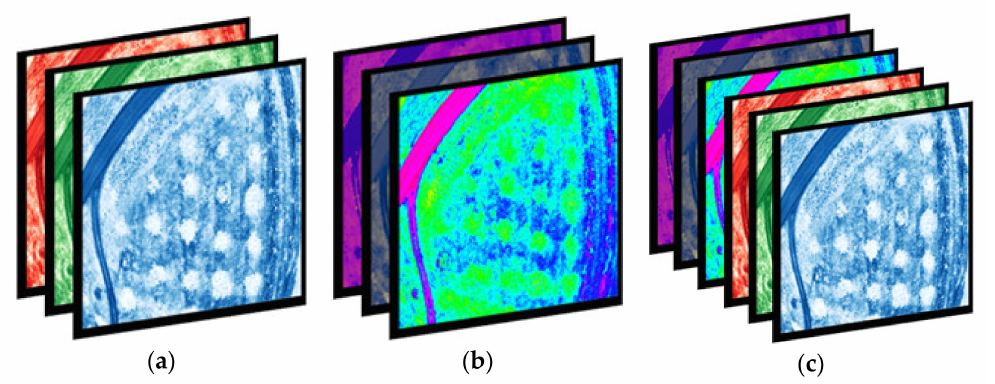
Figure 3. Channel deconstructing of ( a ) RGB, ( b ) HSV, and ( c ) fused